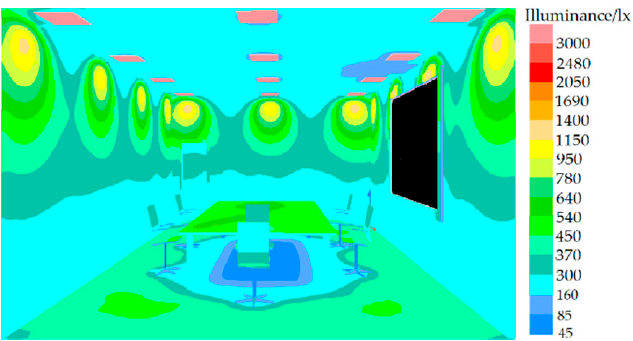
Figure 10. Pseudo-color graph of room space illuminance distribution.